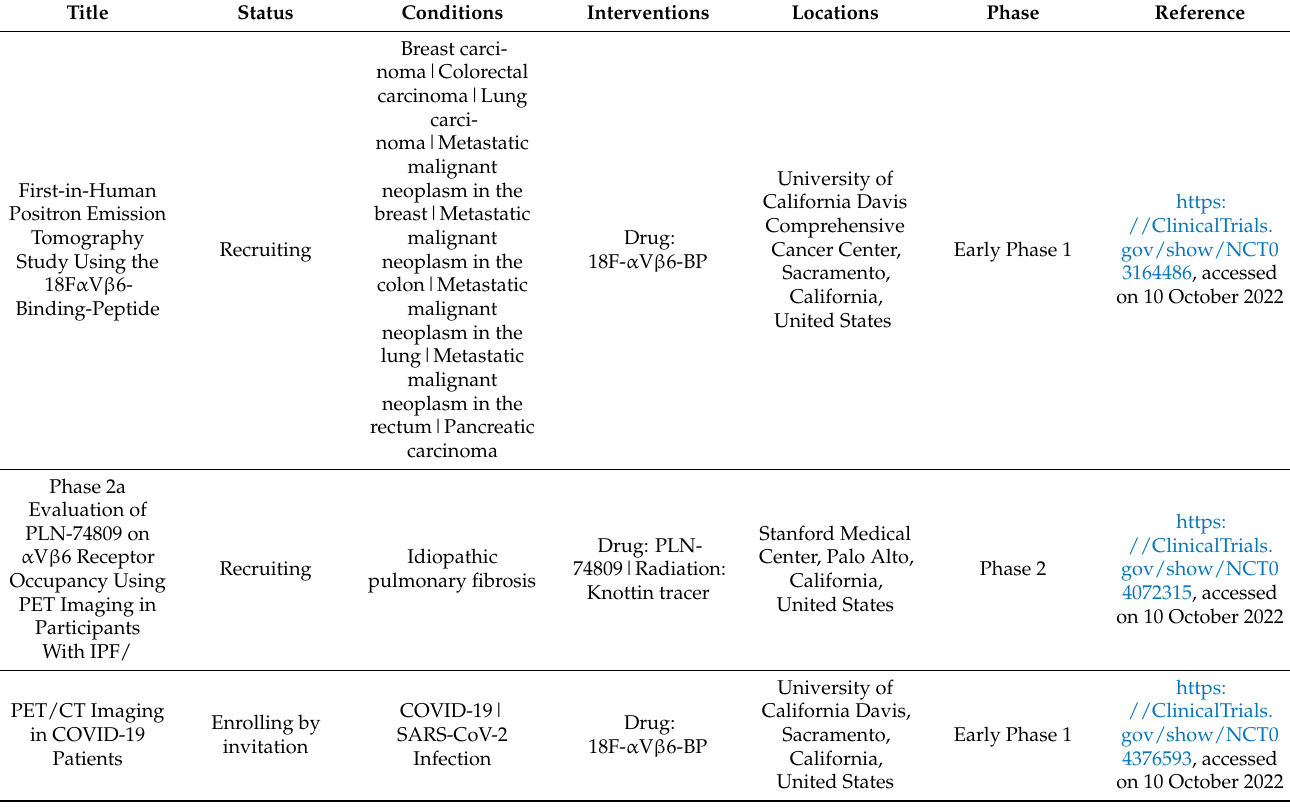
Table 3. (Search of α v β 6-List Results-ClinicalTrials.gov, accessed: October 2022 [76]) (see also Table 2). Table 3. List of active clinical trials with AvB6 in therapeutic settings and imaging. Different stages of clinical phase development are indicated. Retrieved from ClinicalTrials.gov, accessed on 10 October 2022